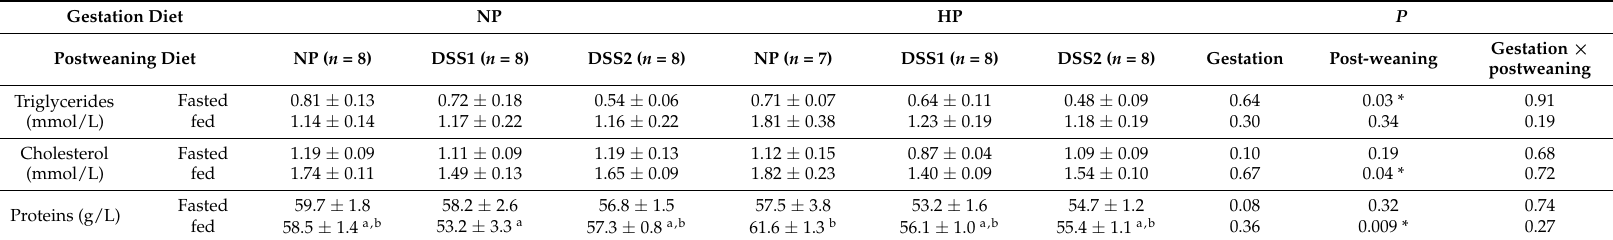
Table 3. Metabolites in plasma on